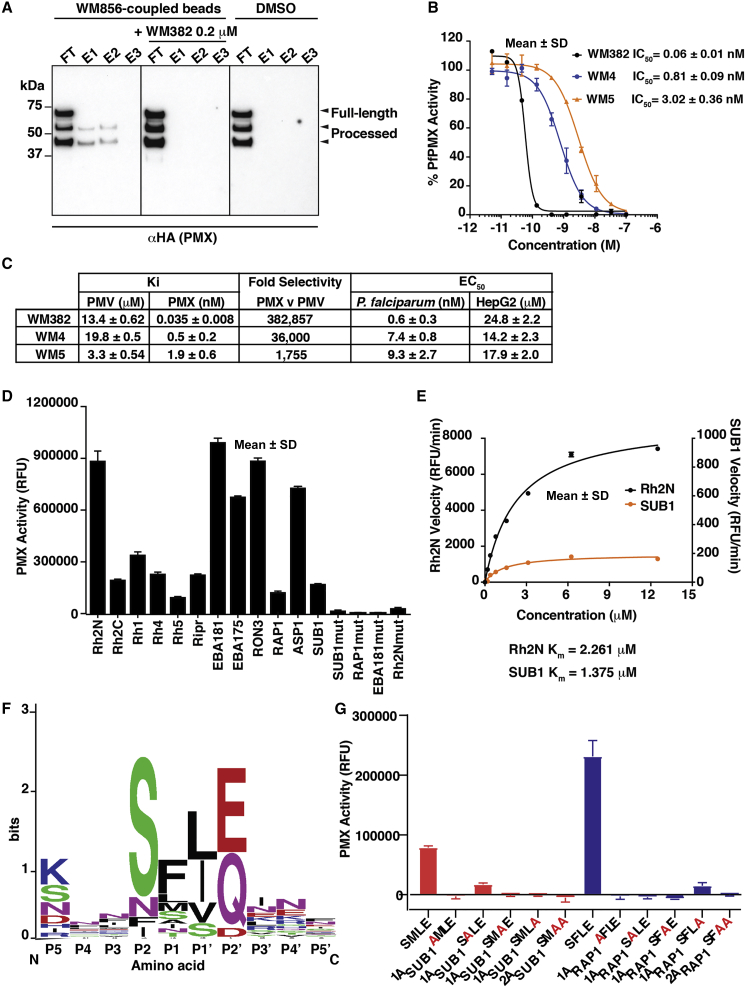
Enzyme Activity, Selectivity, and Substrate Specificity of rPMX(A) PMX-HA immuno-detection after pull-down with WM856. FT, flow through; E1, E2, E3, elution fractions. Left: unbound and eluted proteins from WM856-coupled beads. Center: with 0.2 μM WM382. Right: Uncross-linked beads.(B) IC50 for WM382, WM4, and WM5 inhibition of PMX with Rh2N peptide. Mean ± SD.(C) Ki, for WM382,WM4, and WM5 with PMV and PMX, EC50 for P. falciparum and HepG2 cells. Mean ± SD (three experiments).(D) rPMX activity for peptide cleavage. Mutant controls, mut; RFU, relative fluorescence units. Mean ± SD.(E) Rate of enzyme activity and Km of rPMX for Rh2a/b and SUB1. Mean ± SD.(F) Sequence logo of amino acids P5-P5′ positions.(G) Cleavage of peptides containing SUB1 (red) and RAP1 (blue) sequences and alanine substitutions by rPMX. Mean ± SD.